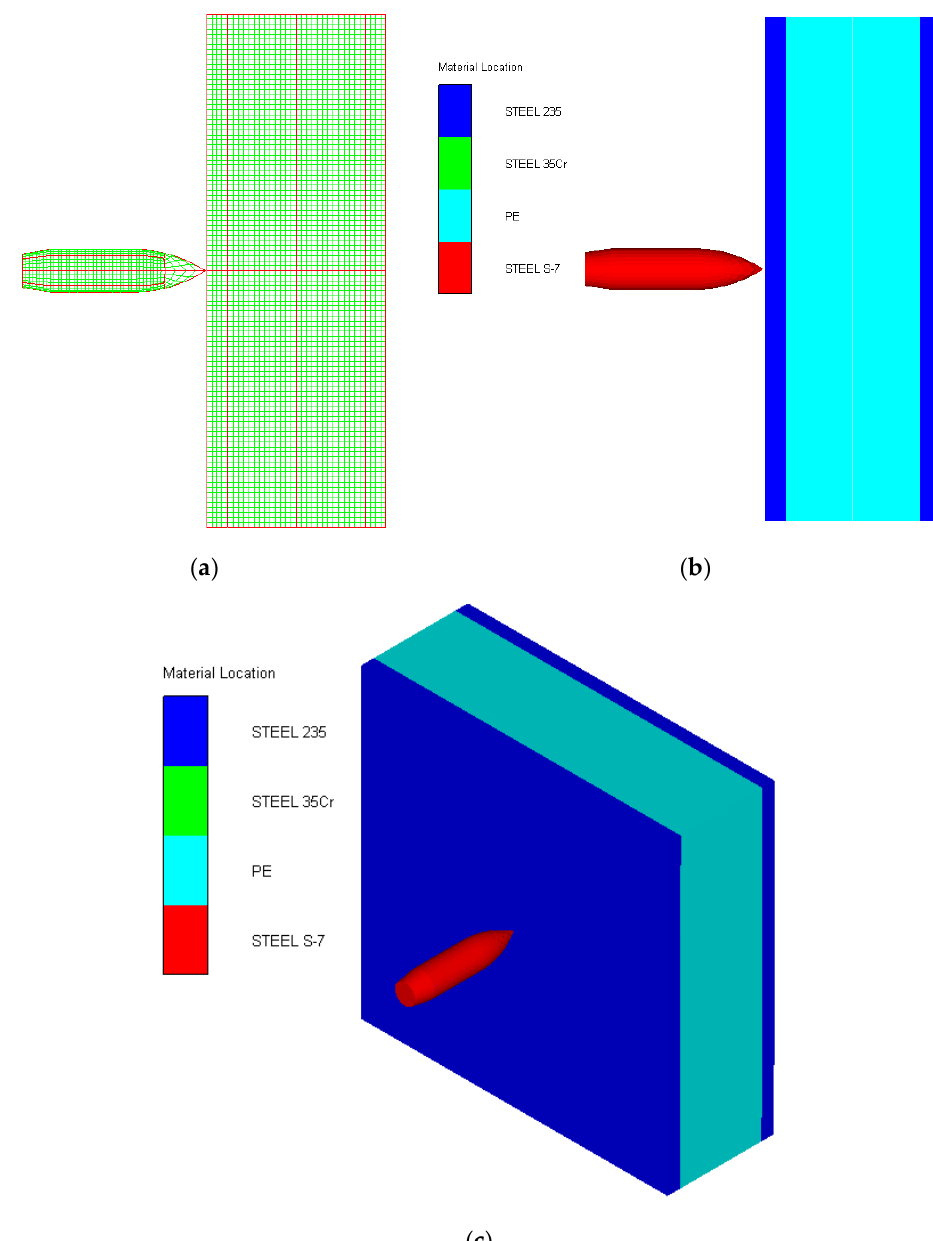
Figure 10. Numerical model of UHMWPE composite armor and the sharp head penetrator. ( a ) Grid model. ( b ) Side view of numerical model. ( c ) Isometric side view of numerical model.